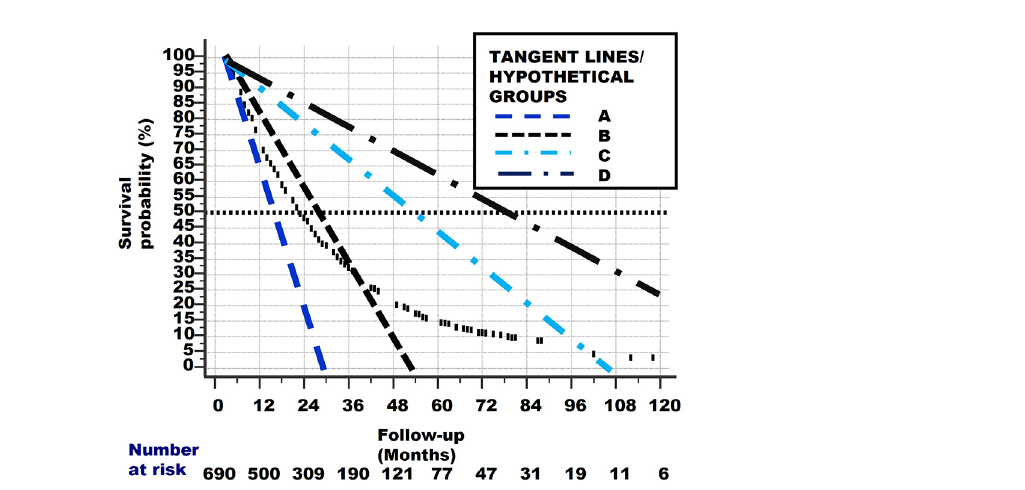
FIGURE 9 | The original curved survival line is shown as small vertical black lines. The linear tangent lines of the curved survival line from Figures 7 and 8 , between points P – Q, Q – R, R – S and S – T, are extrapolated from where they originally begun, at point P.